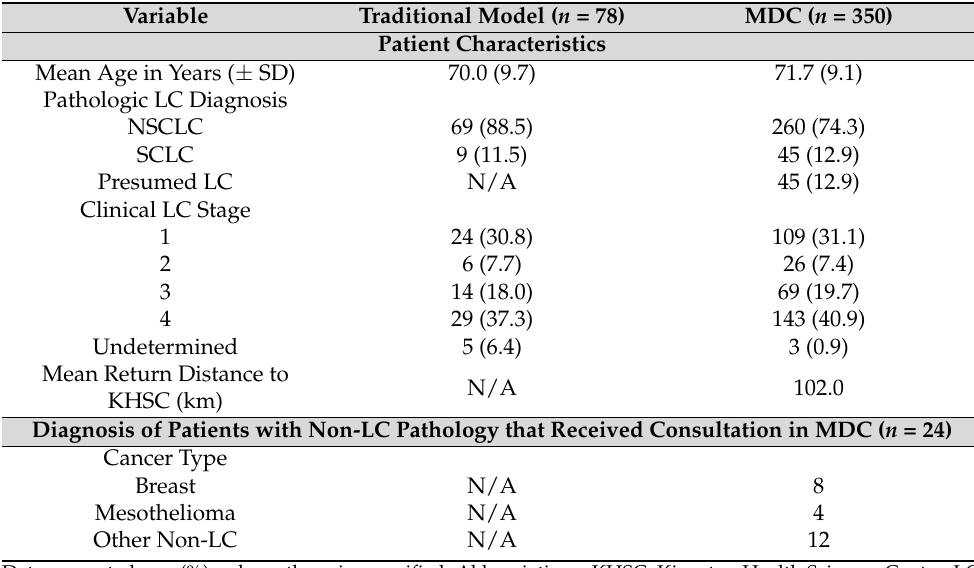
Table 1. Patient demographics in the traditional and multidisciplinary clinic models.